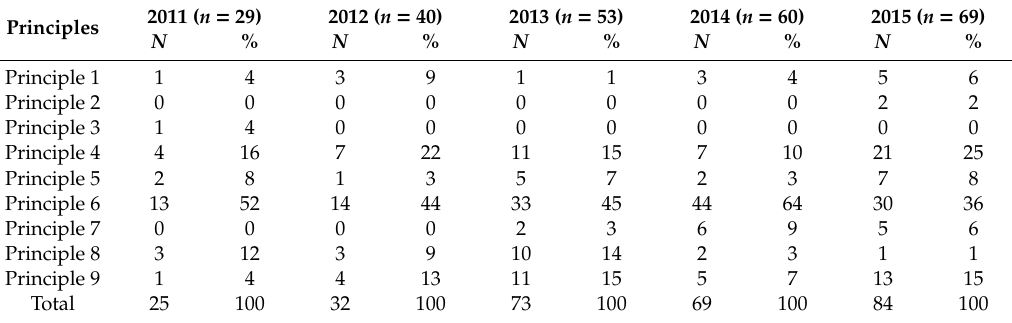
Table 6. Frequency of major non-conformities (NCs) in NW Russia 2011–2015.